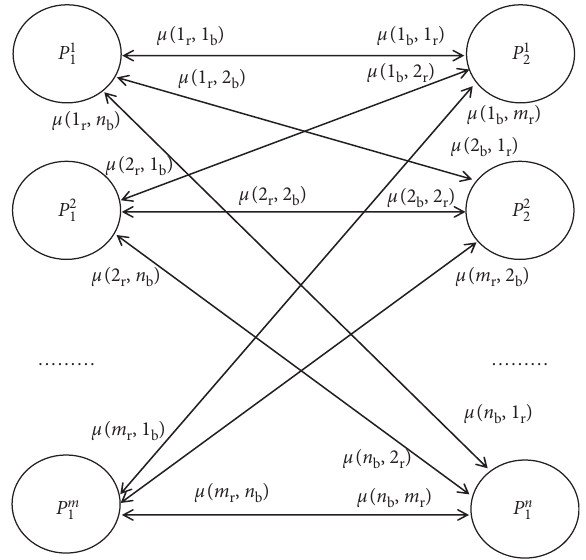
Figure 2: Interpretation of the task of target assignment in the form of a fuzzy bichromatic